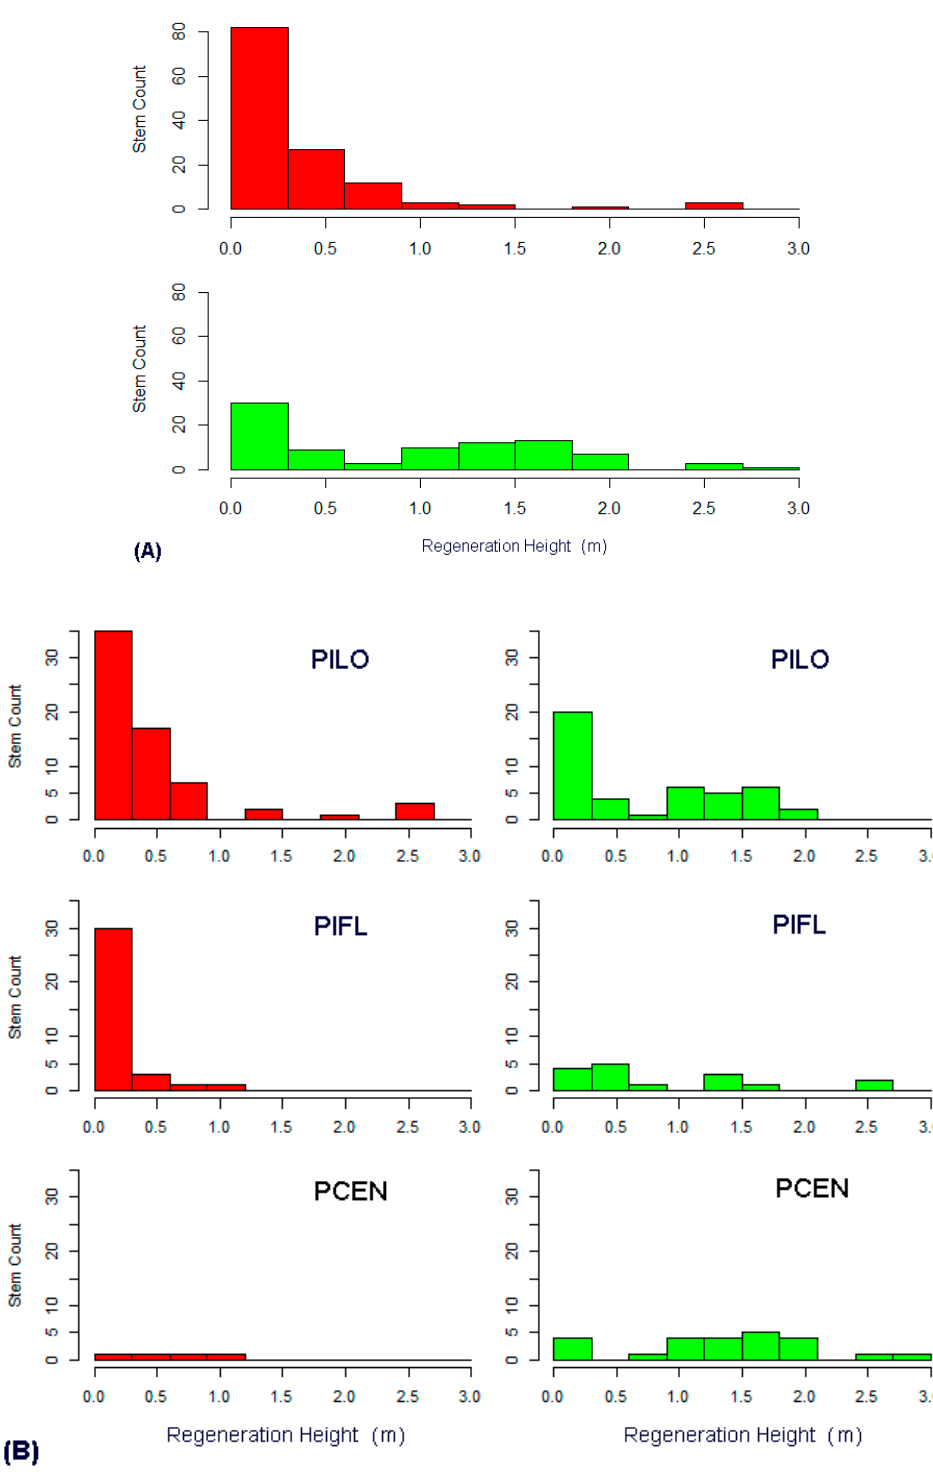
Figure 5. Histograms of regeneration size based on 30-cm height classes for plots inside the fire parameter (“burned”, red bars) and outside of it (“unburned”, green bars). The smallest size class, 30 cm or less, identifies seedlings, while the remaining size classes, up to 3 m, represent saplings. ( A ) All species combined. ( B ) Species-specific histograms: PILO = Pinus longaeva ; PIFL = Pinus flexilis ; PCEN = Picea engelmannii .